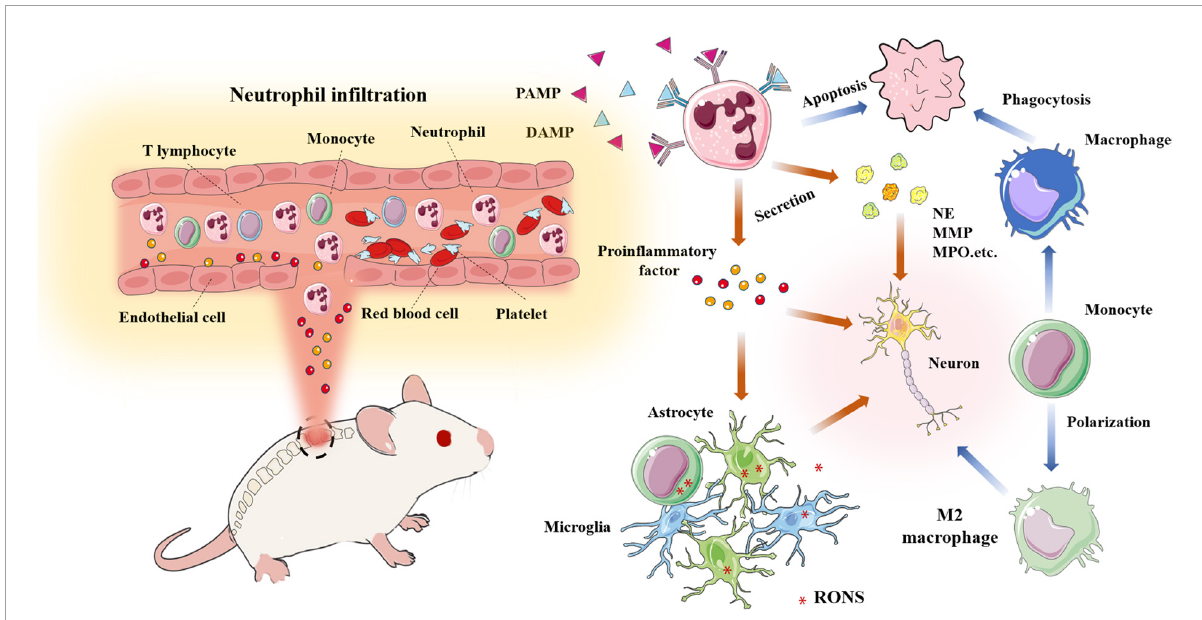
FIGURE5 A large number of neutrophils infiltrate into the damaged site and release pro-inflammatory factors and chemokines; Neutrophils release various harmful enzymes (MMP, NE, MPO,etc); Activated monocytes, microglia, astrocytes,etc produce RONS, resulting in the deterioration of the microenvironment; Macrophages phagocytize apoptotic neutrophils and transform into M2